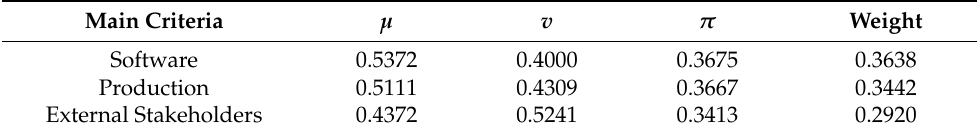
Table 5. Spherical fuzzy and defuzzified weights for main criteria.